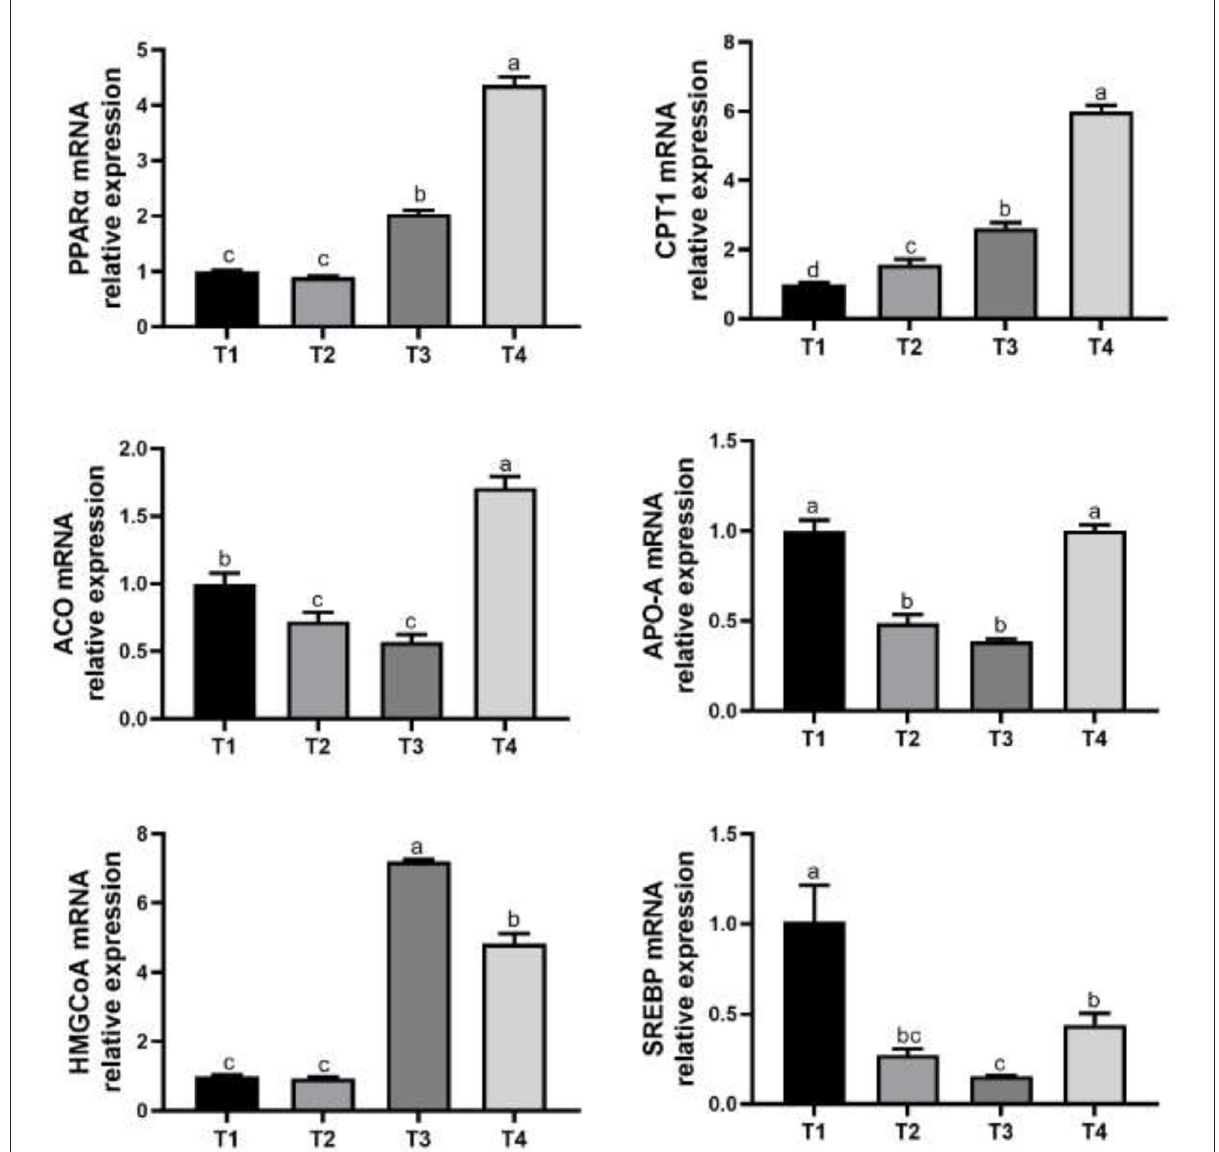
FIGURE1 Effects of PPAR- α agonist on genes expression related to liver fat metabolism in broilers. T1, normal corn diets group; T2, normal corn + Wy-14643 diets group; T3, mycotoxin-contaminated corn diets group; T4, mycotoxin-contaminated corn + Wy-14643 diets group. The a, b, c, and d different letters indicate the significant